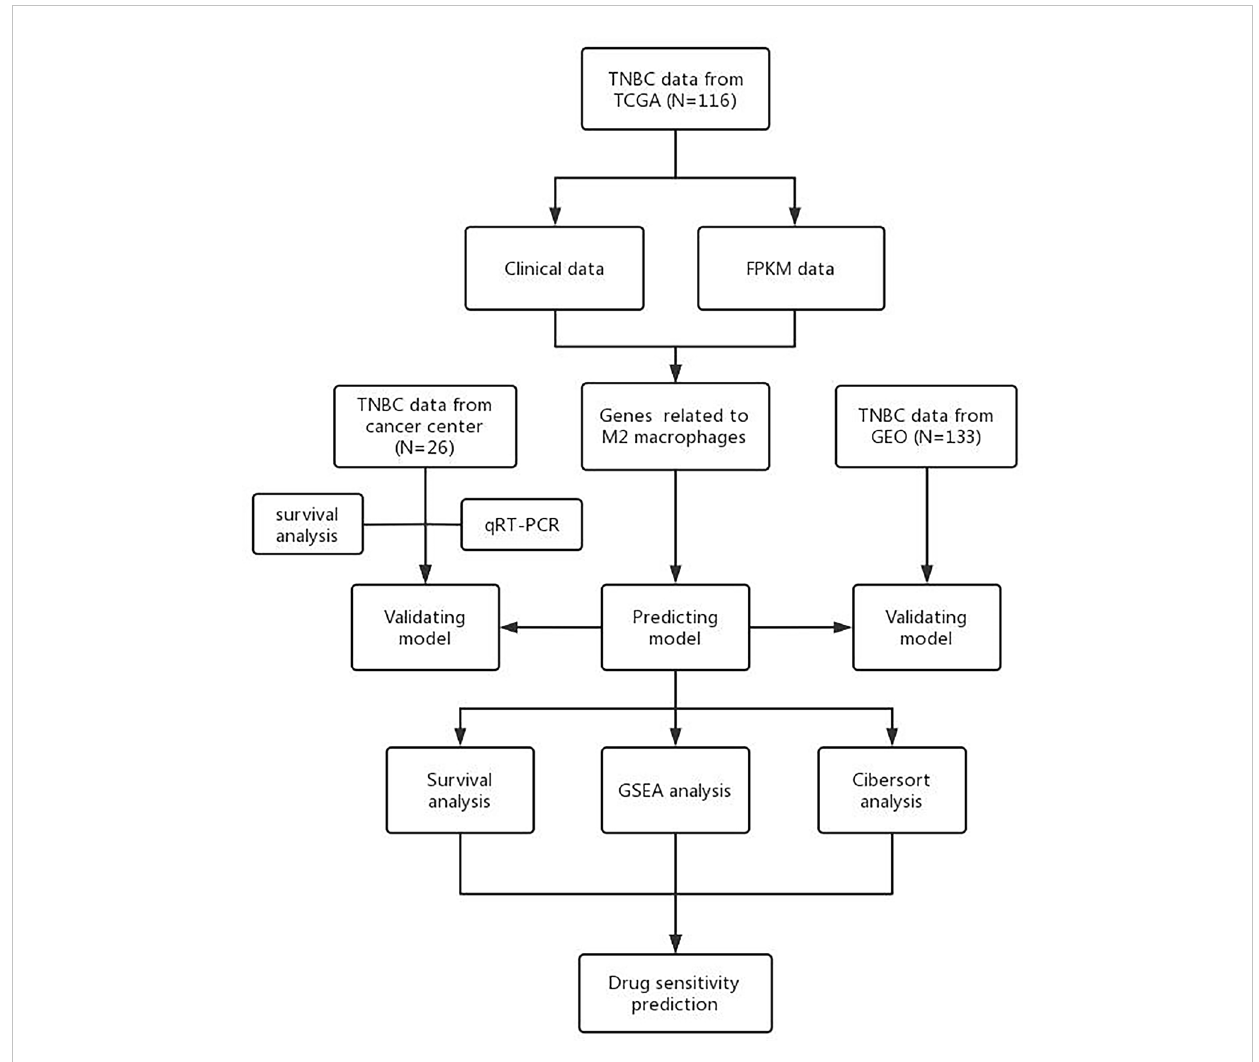
FIGURE 1 Research